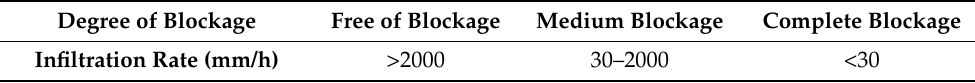
Table 1. Degree of blockage of PICPS and related infiltration rates based on Lucke et al. [14]. Degree of Blockage Free of Blockage Medium Blockage Complete Blockage Infiltration Rate (mm/h) >2000 30–2000